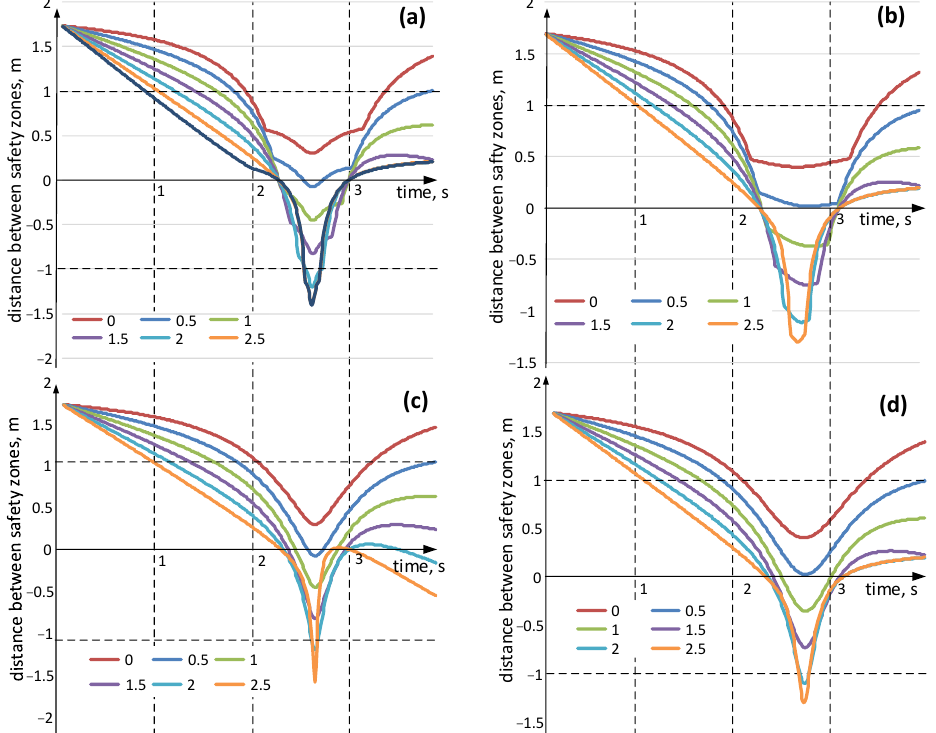
Figure 8. Distance in y -axis direction between safety zones for different lateral speeds (km/h) of the obstacle: ( a ) vehicle—rectangle, obstacle—circle; ( b ) vehicle—rectangle, obstacle—ellipse; ( c ) vehicle—ellipse, obstacle—circle; ( d ) vehicle—ellipse, obstacle—ellipse.